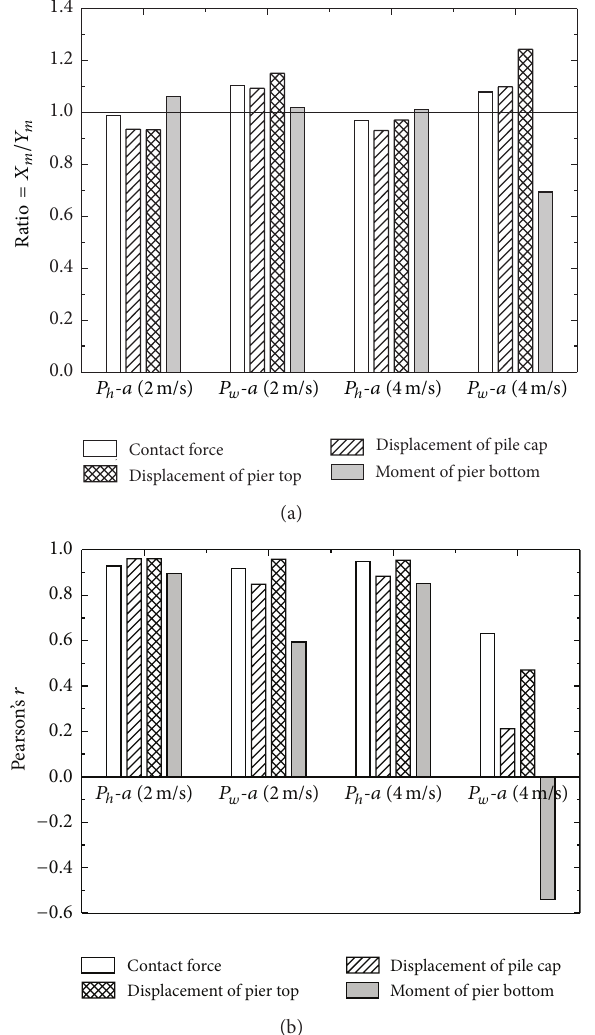
Figure 21: (a) Analysis of peak response; (b) Pearson’s correlation with the high-resolution